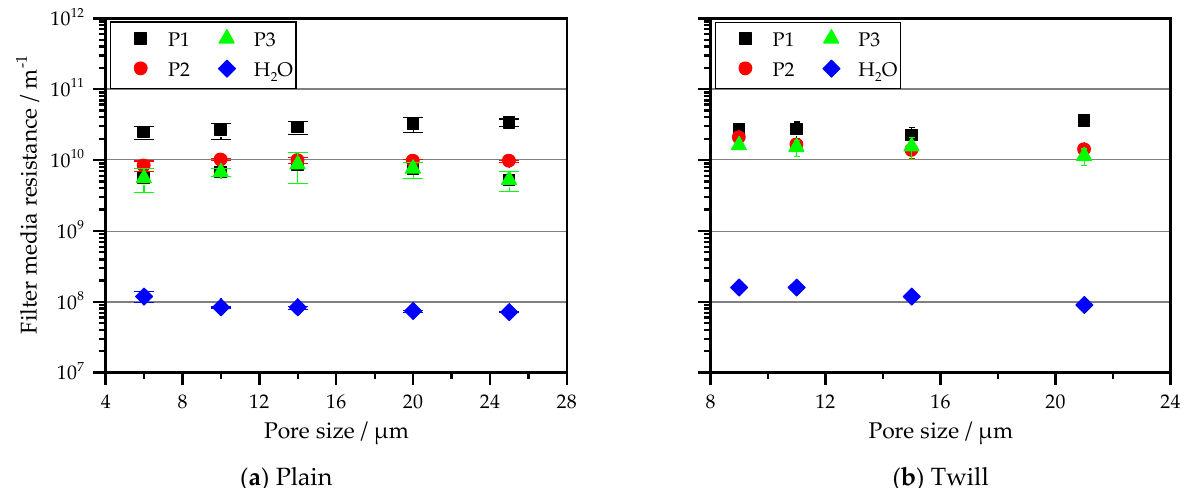
Figure 8. Overview of the fabric resistances in m −1 of monofilament metal-based plain ( a ) and twill ( b ) fabrics (Table 3) with interaction of the particles from Figure 2.